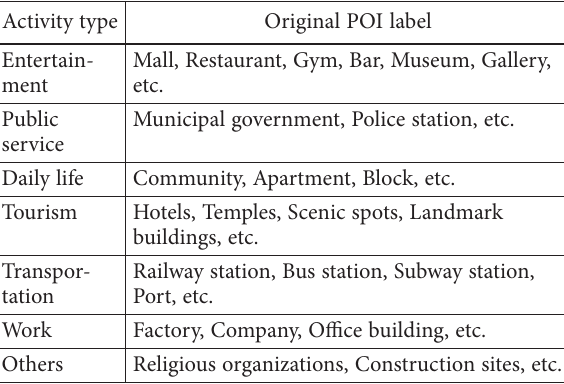
Table 3. Classification of check-in points (Yan et al., 2019) Activity